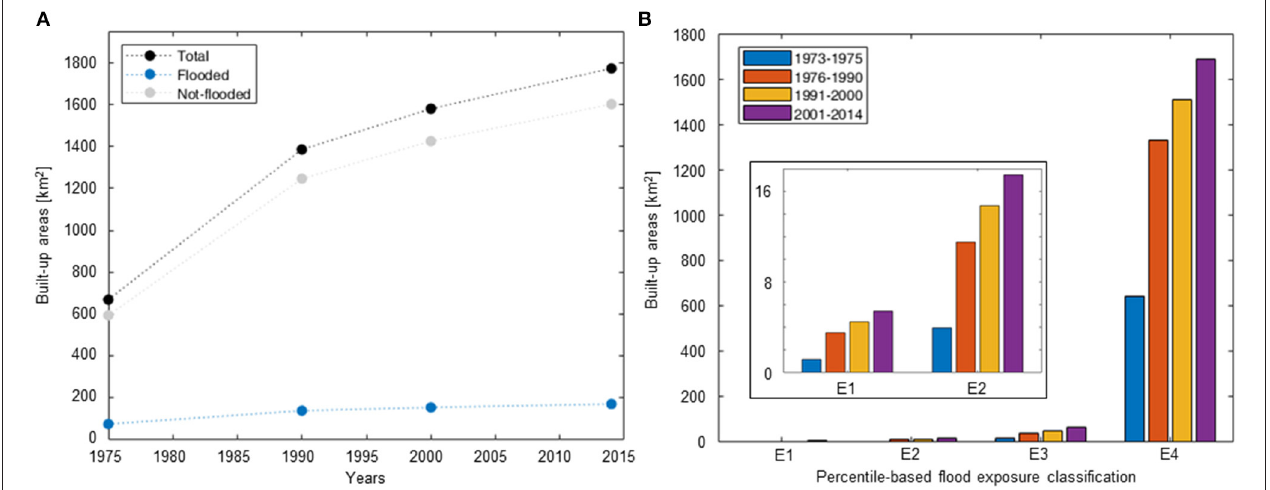
FIGURE 4 | Flood exposure assessment across the MDB from 1973 to 2014. (A) Temporal evolution of the actual maximum extension of built-up areas (in km 2 ), distinguishing between total (black), flooded (blue) and not-flooded (gray) locations. (B) Temporal evolution of the maximum extension of built-up areas (in km 2 ) in each flood exposure category (percentile-based classification). The inset shows a zoom for classes E1 and E2.